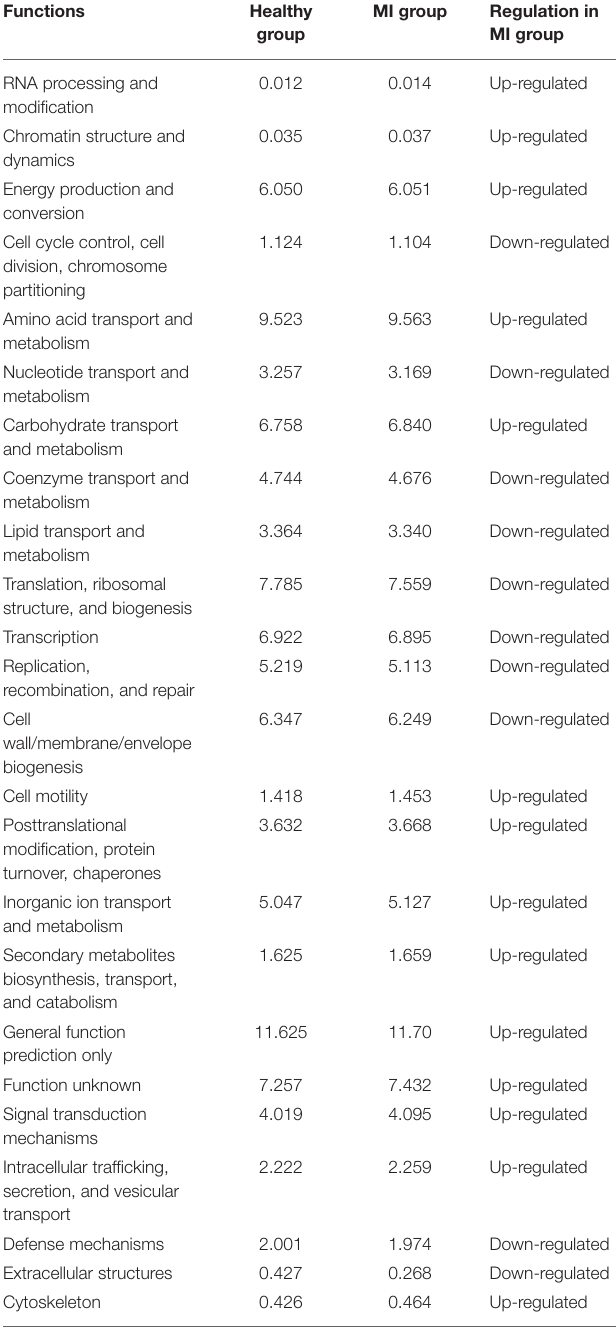
TABLE 3 | COG functional analysis between patients with MI and HC.